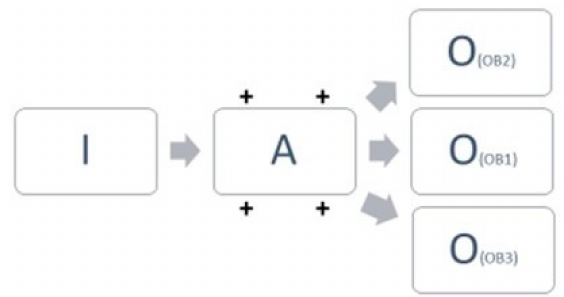
Figure 2. Process evolution type